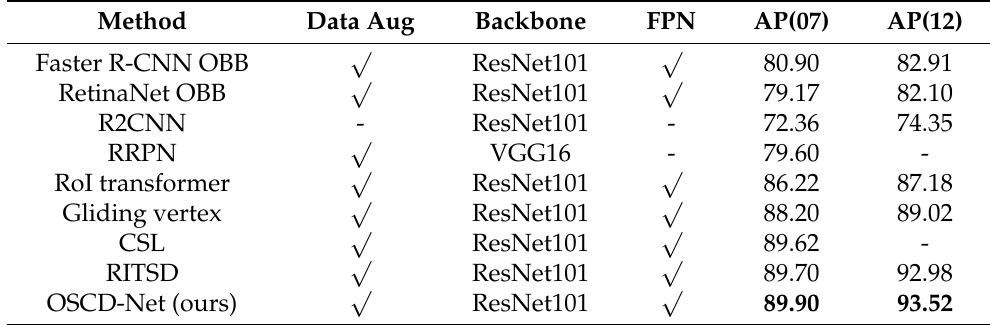
Table 3. Performance evaluation of nine different methods on HRSC2016 dataset. The highest value is indicated by bold numbers (%).